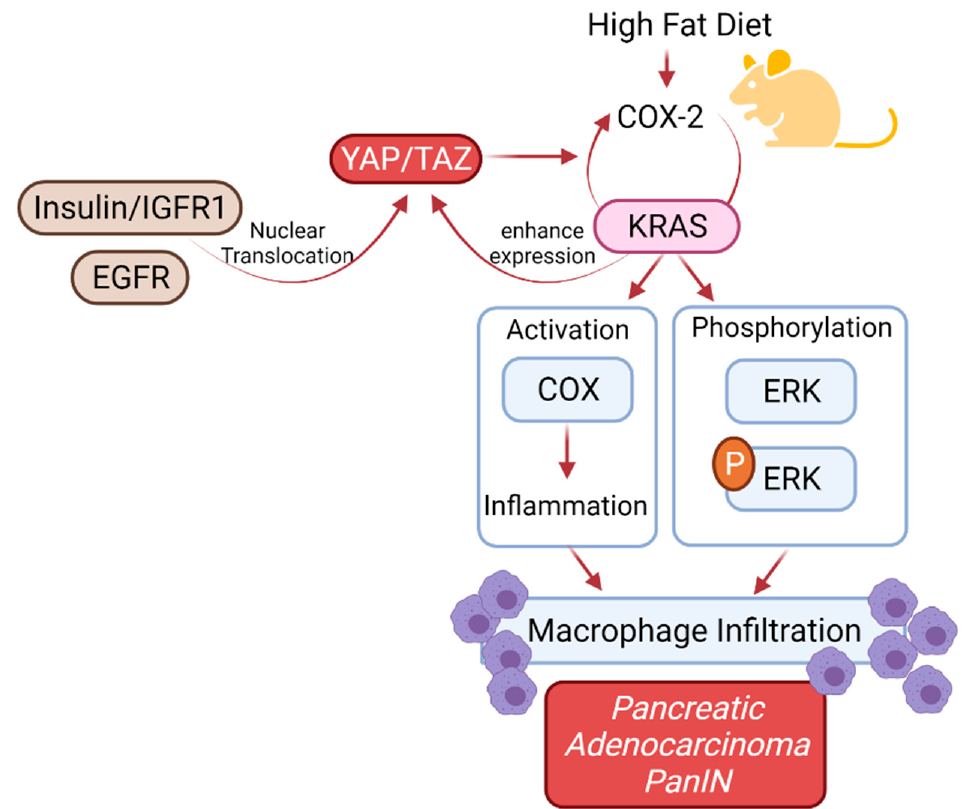
Figure 3. A high-fat diet (HFD) can initiate the transformation of normal pancreatic cells into PanIN lesions. This KRAS activation via HFD leads to downstream activation of COX2 and ERK phosphorylation, thus resulting in infiltration of macrophages into the stroma and formation of a pro-tumorigenic microenvironment.